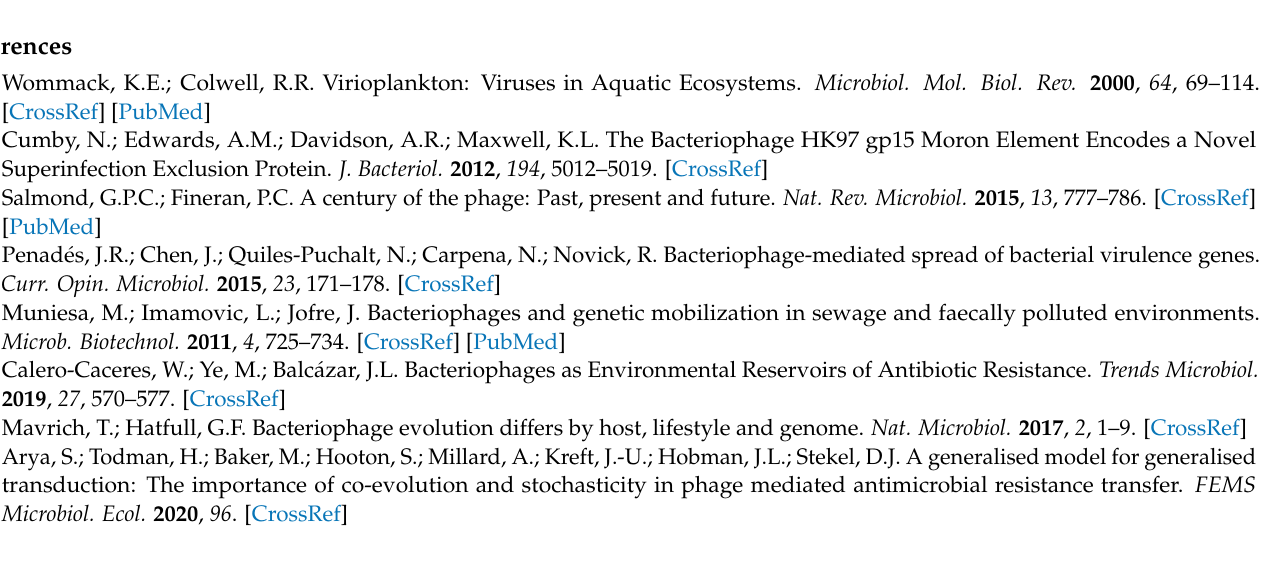
ARG, Table S3: Conditions and results of qPCR for 11 ARGs, Table S4: Results of amino acid sequence alignments of tail fiber, ribonucleotide reductase and holin between Enterobacteria phage T4 or RB3 and phage AH67C600_Q9, Table S5: Matching positions of contigs to ARGs for E. coli AH67C600, Figure S1: Amino acid sequence alignments of tail fiber, ribonucleotide reductase and holin